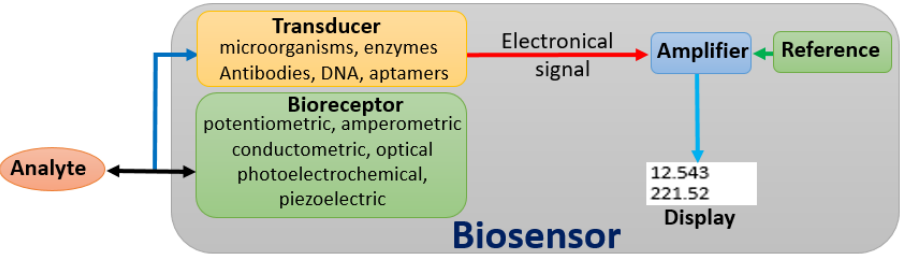
Figure 1. The basic components of biosensor. The black, blue and red arrows symbolize the chemical interaction, biochemical signal, and detectable electric signal, respectively .